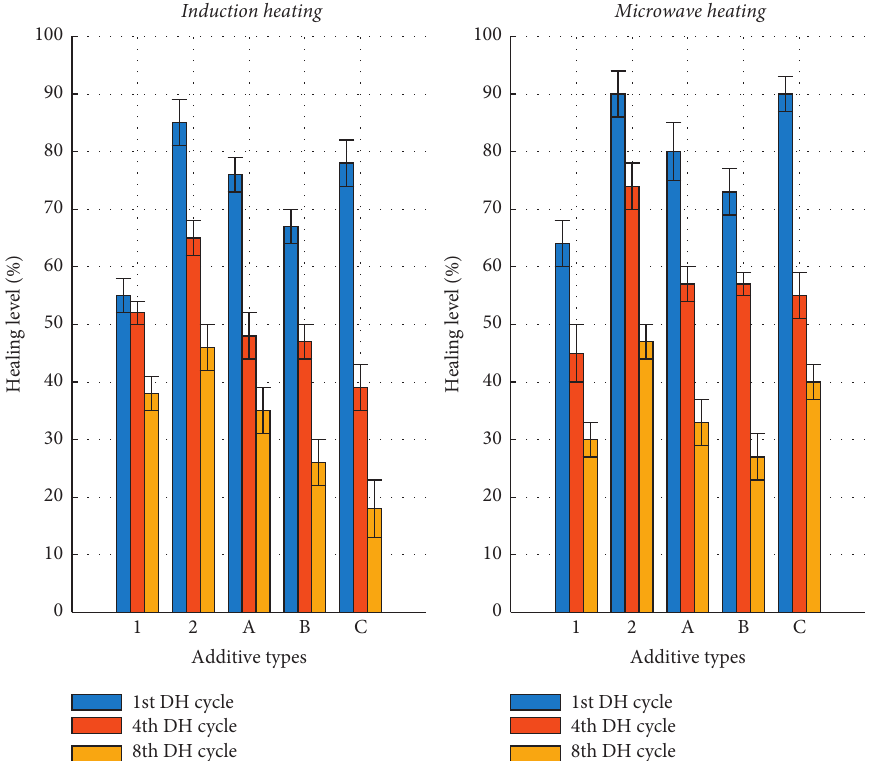
Figure 9: Healing level of unaged mixtures with moisture damage (1 FT cycle).